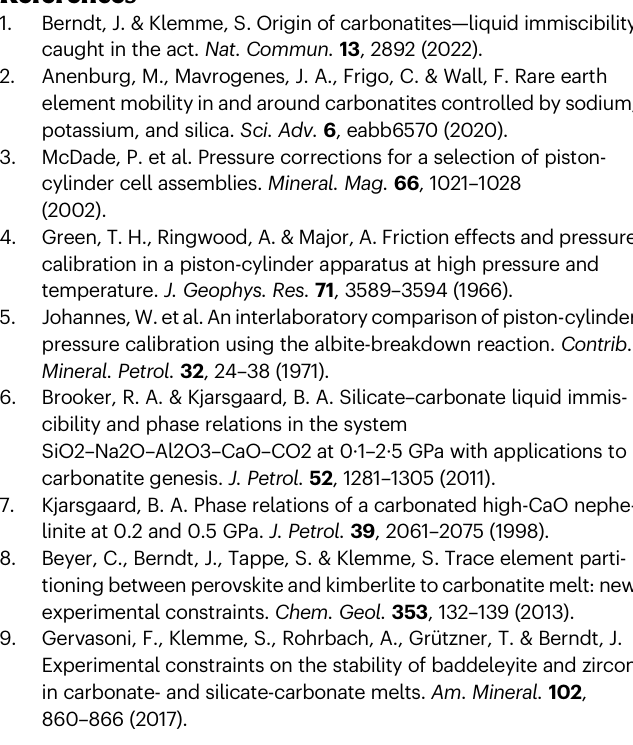
(Lc), neither in BSE images nor in X-ray maps. The meltinclusion (iii) does contain small silicate blebs in the carbonatite. Only melt inclusions without silicate blebs were used for quantitative analyses.